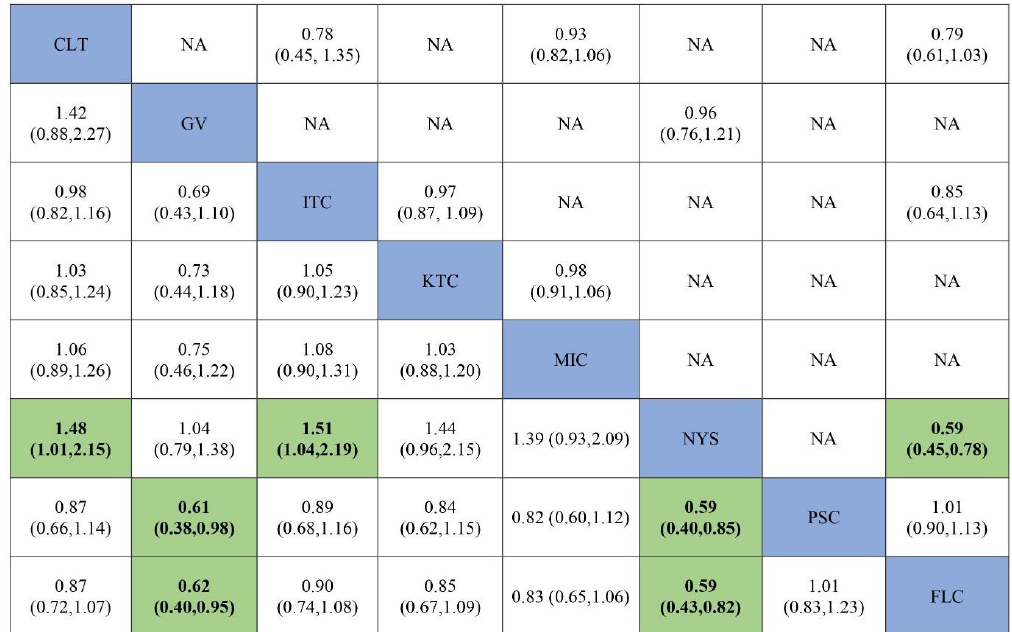
Figure 4. SUCRA ranking curve of antifungal agents used for the treatment of OPC among HIV-